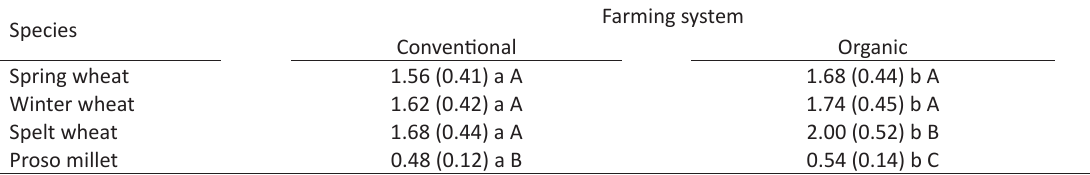
Table 5. O-dihydroxyphenol content (the total expressed as caffeic acid equivalents) in cereal grain (g kg -1 ); mean for